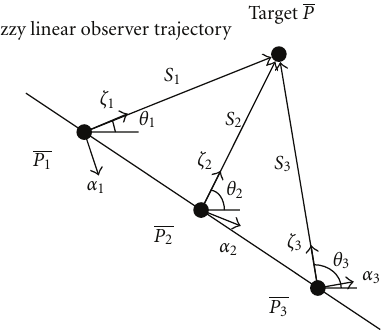
Figure 1: Fuzzy geometry for bearings-only target localization (3 sensors along fuzzy linear observer trajectory) in R 2